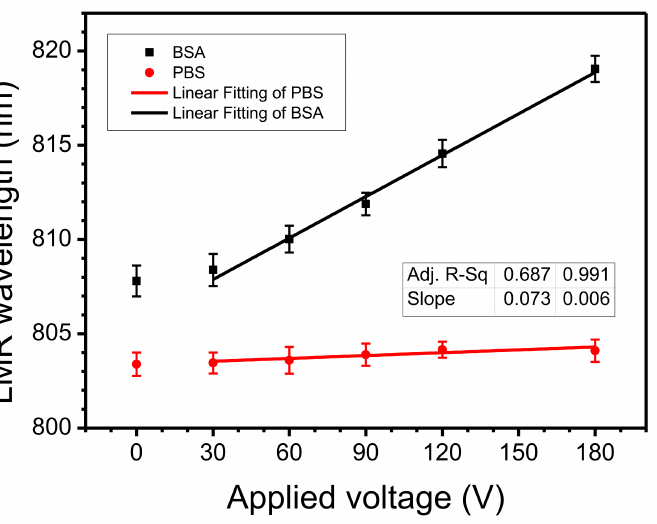
Figure 4. Variation in LMR wavelength shift for 1% BSA and phosphate-buffered saline (PBS) solution for 100 s using applied voltages from 0 to 180